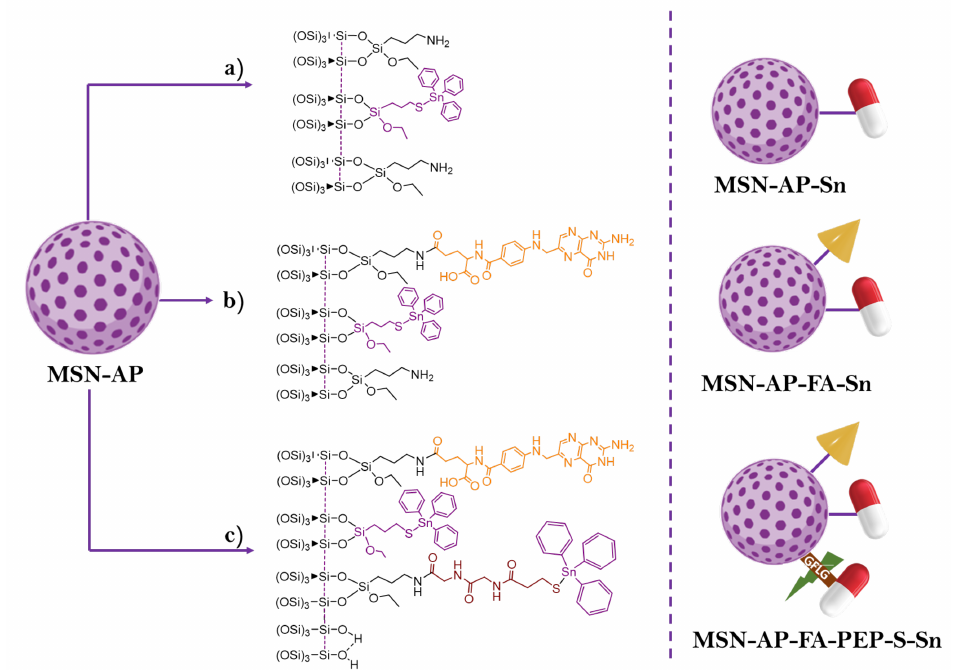
Figure 9. General synthetic strategy for the preparation of the three mesoporous silica systems. Purple moiety: organotin(IV) cytotoxic compound, red: enzyme-responsive linker; orange: folate fragment. ( a ) Incorporation of the cytotoxic agent, ( b ) incorporation of the targeting molecule and ( c ) incorporation of organotin(IV) fragment through an enzyme-response peptide. Adapted from reference [90]. Copyright © Authors of the publication (open